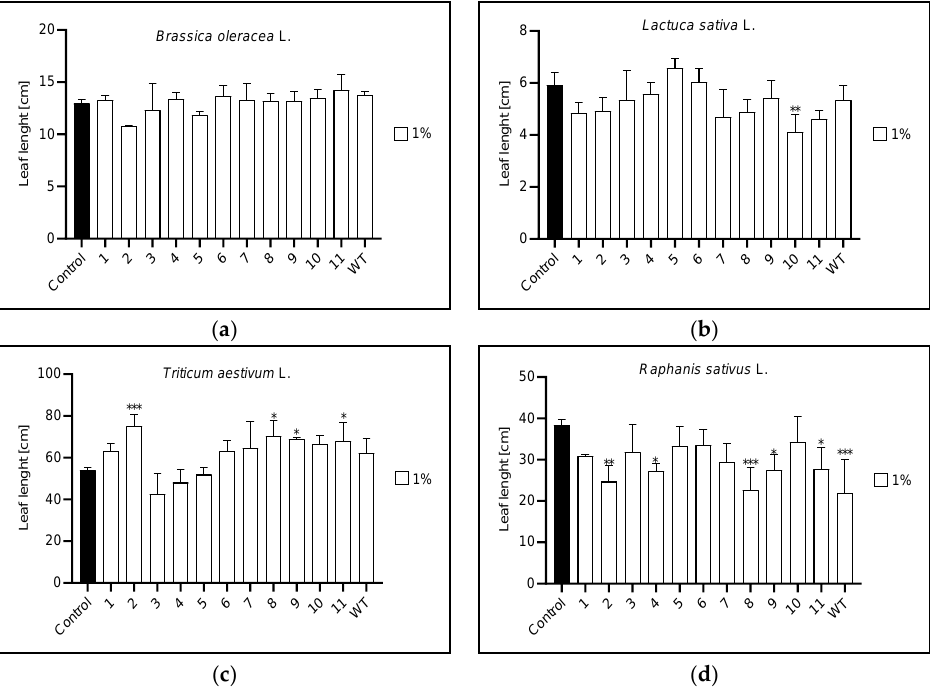
Figure 8 . Leaf length of broccoli ( a ), lettuce ( b ), wheat ( c ), and radish ( d ) sprouts treated with 1% concentration for all algae clones tested (1-11, WT) and control (Control). Values represent mean ± SD, n = 10 plants, * p < 0.1, ** p < 0.01, *** p < 0.001 compared to control (ANOVA and Dunnett ’ s a posteriori test). The use of algae extract at a concentration of 5% caused a slight increase in the length of broccoli sprouts treated with clone 11 (Figure 9a, Table 2). The leaf length of lettuce sprouts decreased under the influence of the first clone and WT (Figure 9b, Table 2). Seven algae clones had an effect on the leaf length of wheat germ (Figure 9c, Table 2). Clone 4 caused a significant reduction in leaf length, while the remaining ones elongated the leaves. Radish sprout leaf length was reduced under the influence of clones 1, 3, and 11 (Figure 9d, Table 2).